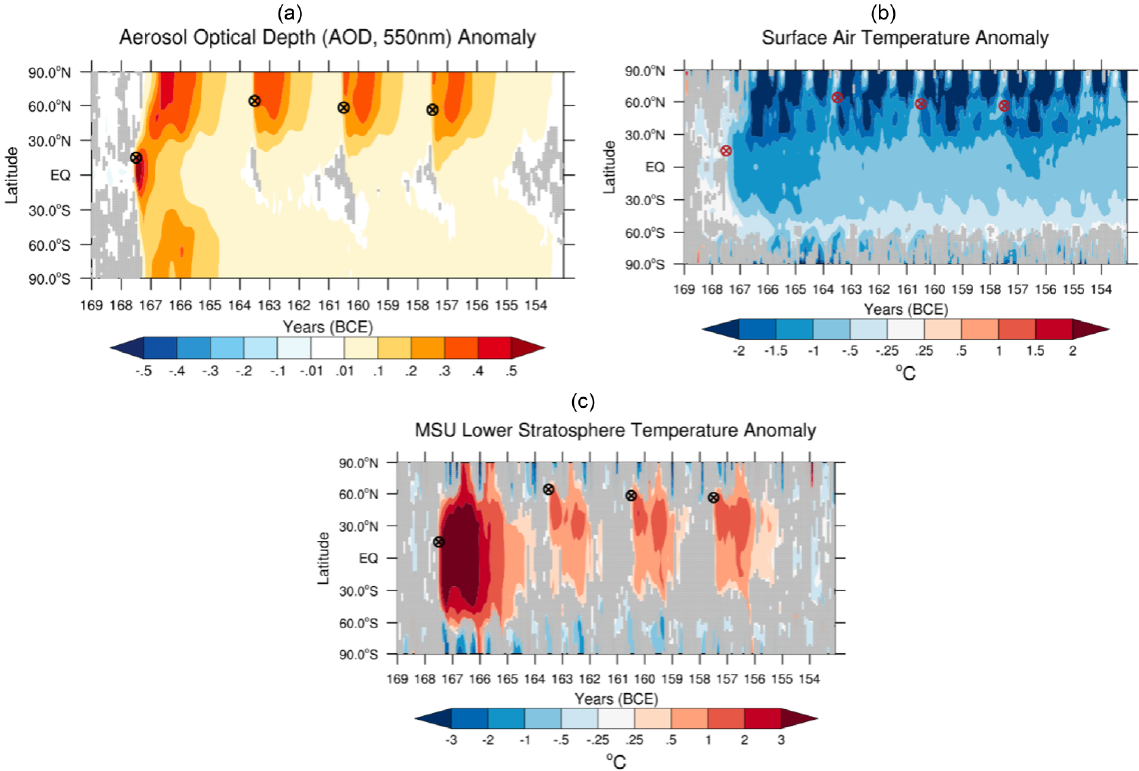
Figure 7. Hovmöller-type plot showing the zonally averaged temporal dispersion of volcanic aerosols in terms of AOD change at 550nm (a) , surface temperature response (b) , and lower stratospheric temperature response (c) . Anomalies were calculated with respect to a climatolog- ical annual cycle obtained from the control simulation. The gray color is painted over regions where changes are not statistically significant at the 95% confidence level. Circled cross marks show the modeled spatial and temporal position of the